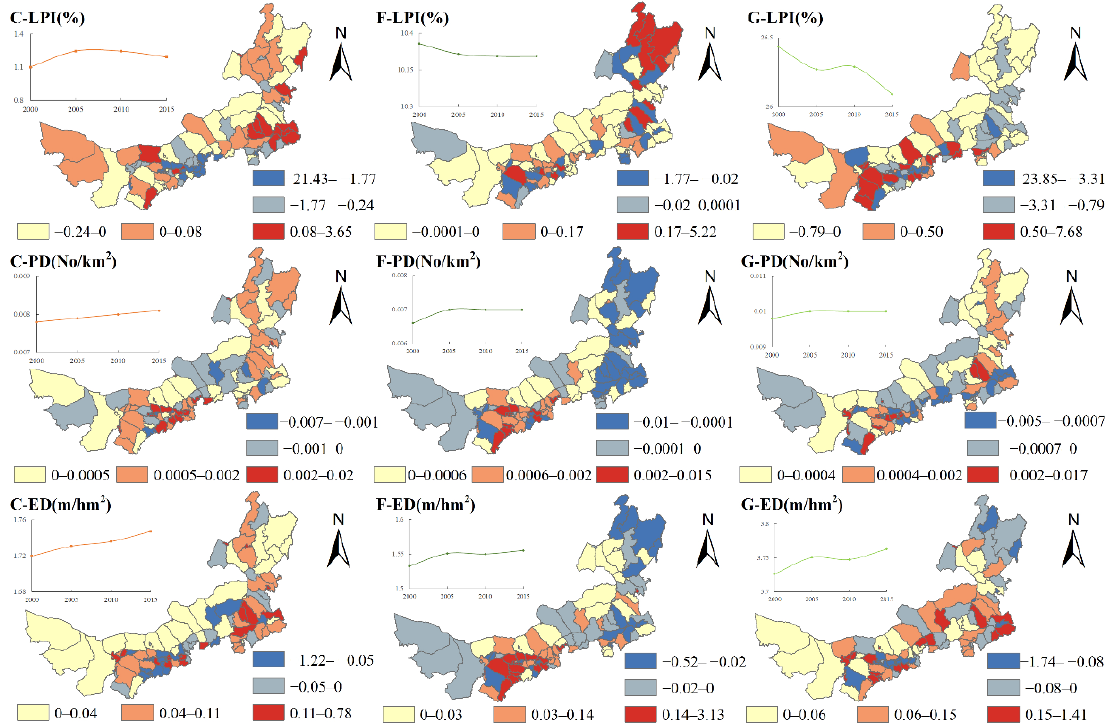
Figure 8. Changes in landscape metrics at the class level in Inner Mongolia from 2000 to 2015. Note: C, cropland; F, forestland; G, grassland; LPI, largest patch index; PD, patch density; ED, edge density.